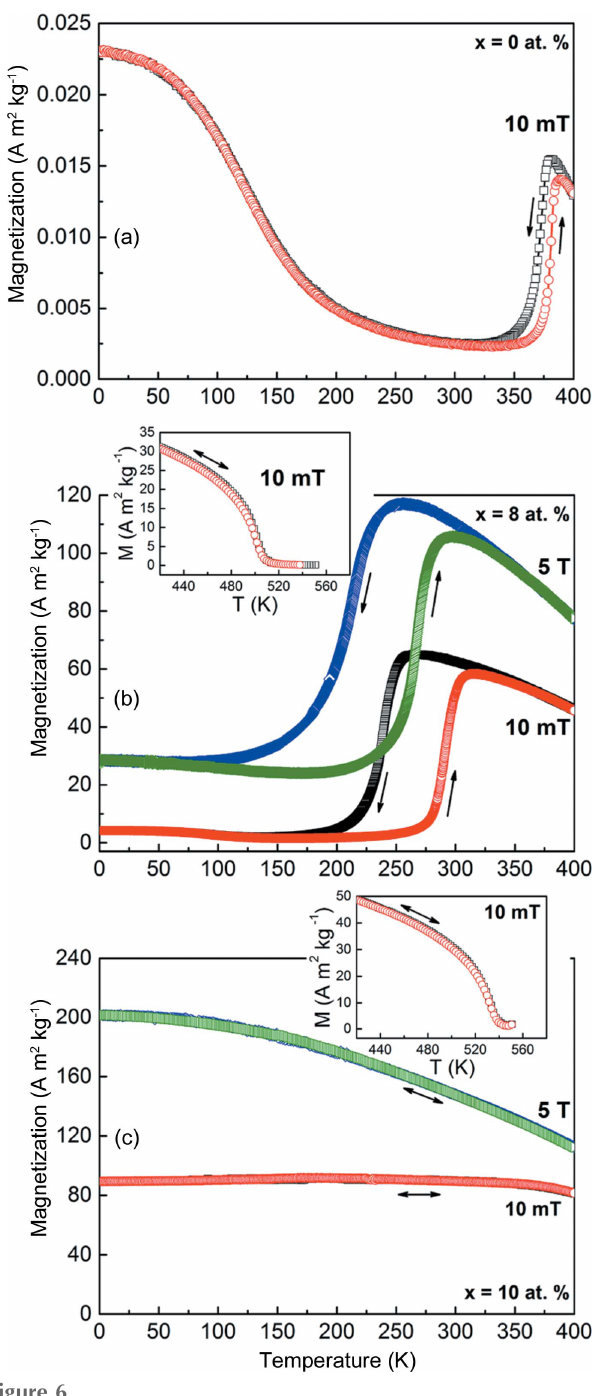
Figure 6 ( a ) M ( T ) curves at 10 mT for Mn 50 Ni 42 Sn 8 ribbons. ( b ) M ( T ) curves at 10 mTand 5 T for Mn 50 Ni 34 Co 8 Sn 8 ribbons. (Inset) M ( T ) curves at 10 mT through the ferromagnetic to paramagnetic transition of austenite. ( c) M ( T ) curves for Mn 50 Ni 32 Co 10 Sn 8 ribbons at 10 mTand 5 T. (Inset) M ( T ) curves at 10 mT through the ferromagnetic to paramagnetic transition of